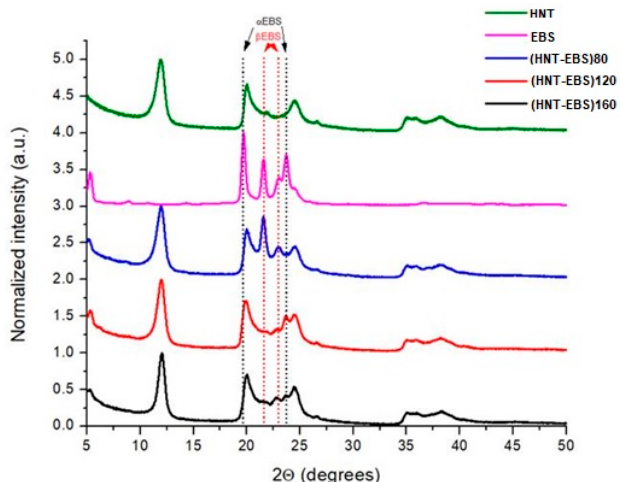
Figure 6. Structures of the EBS-HNT hybrids obtained at different temperature (80, 120, 160 °C). Free EBS occurrence in different crystallizing forms in HNT modified with EBS.